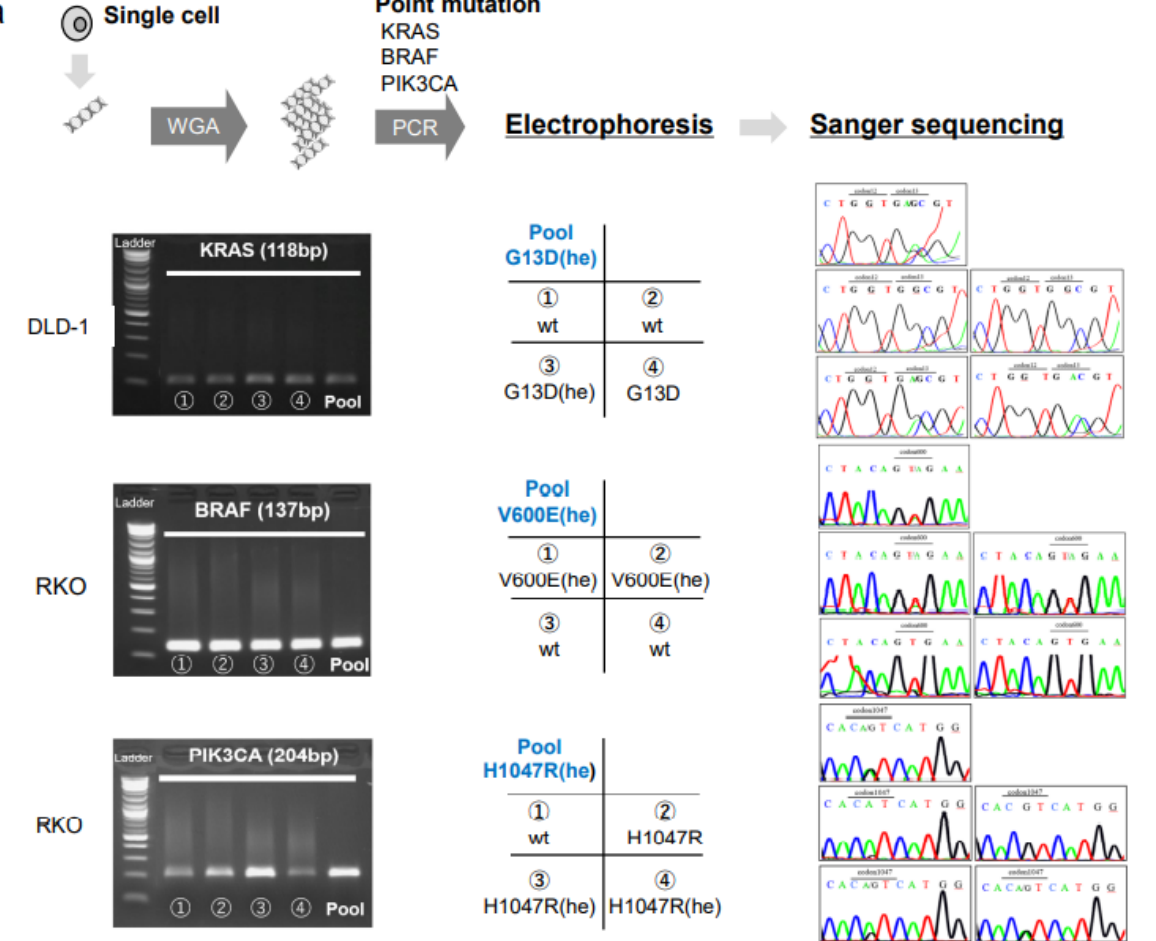
Figure 2. Single cell analyses of mutations in colorectal cancer cell lines. ( a ) DNA isolated from each single cell is subjected to whole genome amplification (WGA), followed by PCR at the hotspot mutation regions and Sanger sequencing. ( b , left column ) Electrophoresis of PCR products show specific amplifications of the KRAS gene in DLD-1 cells , the BRAF gene in RKO cells , and the PIK3CA gene in RKO cells. ( Middle column ) Matrices show the arrangement of data in the right column; Pool: pooled cells; cell numbers (1–4) and the genotypes indicated correspond to the single-cell PCR products shown in the left column; ( Right column ) Sanger sequencing results for each sample, arranged as shown in the middle column. The mutated codons are indicated at the top of each panel. Abbre- Table 1. single cell analysis (CRC cell line).